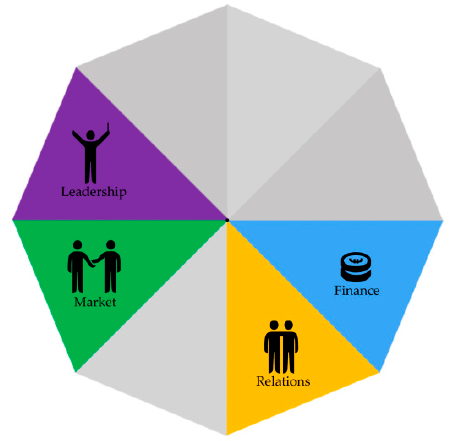
Figure 7. Addressing feeling of engagement.